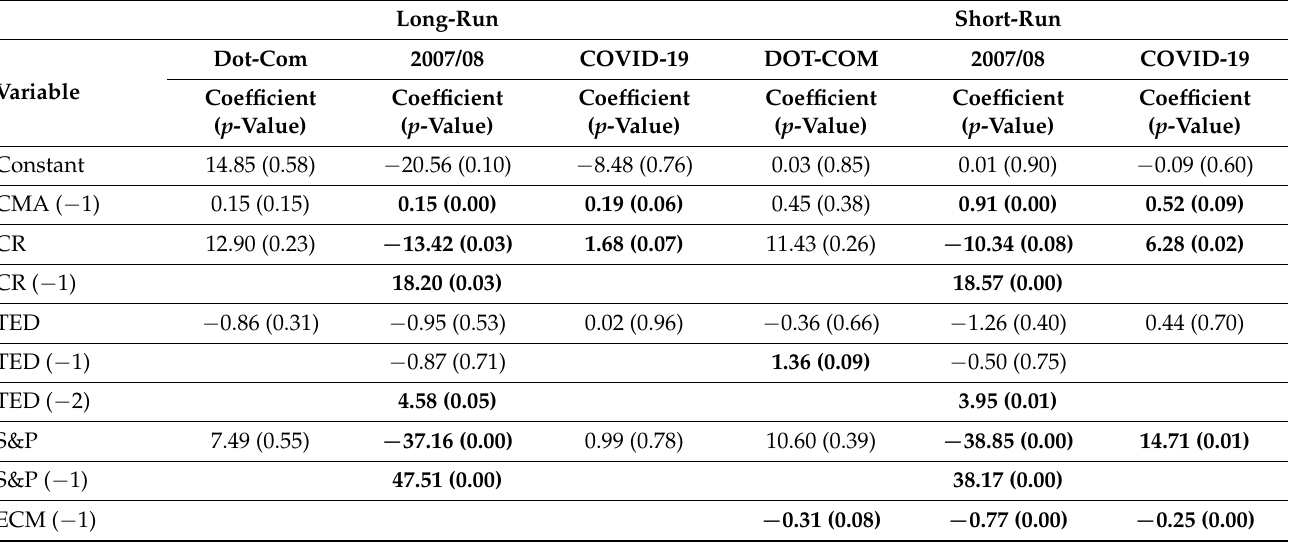
Table 17. Long-run ARDL model and short-run error correction model for CMA